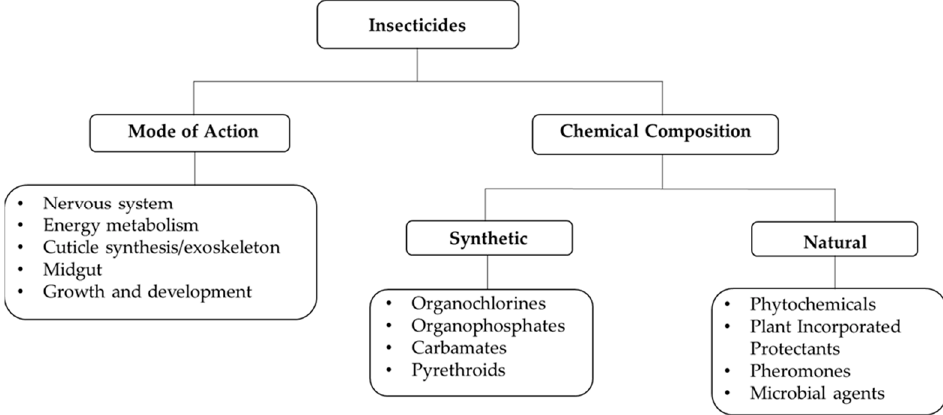
Figure 1. Classification of insecticides based on mode of action and chemical composition.